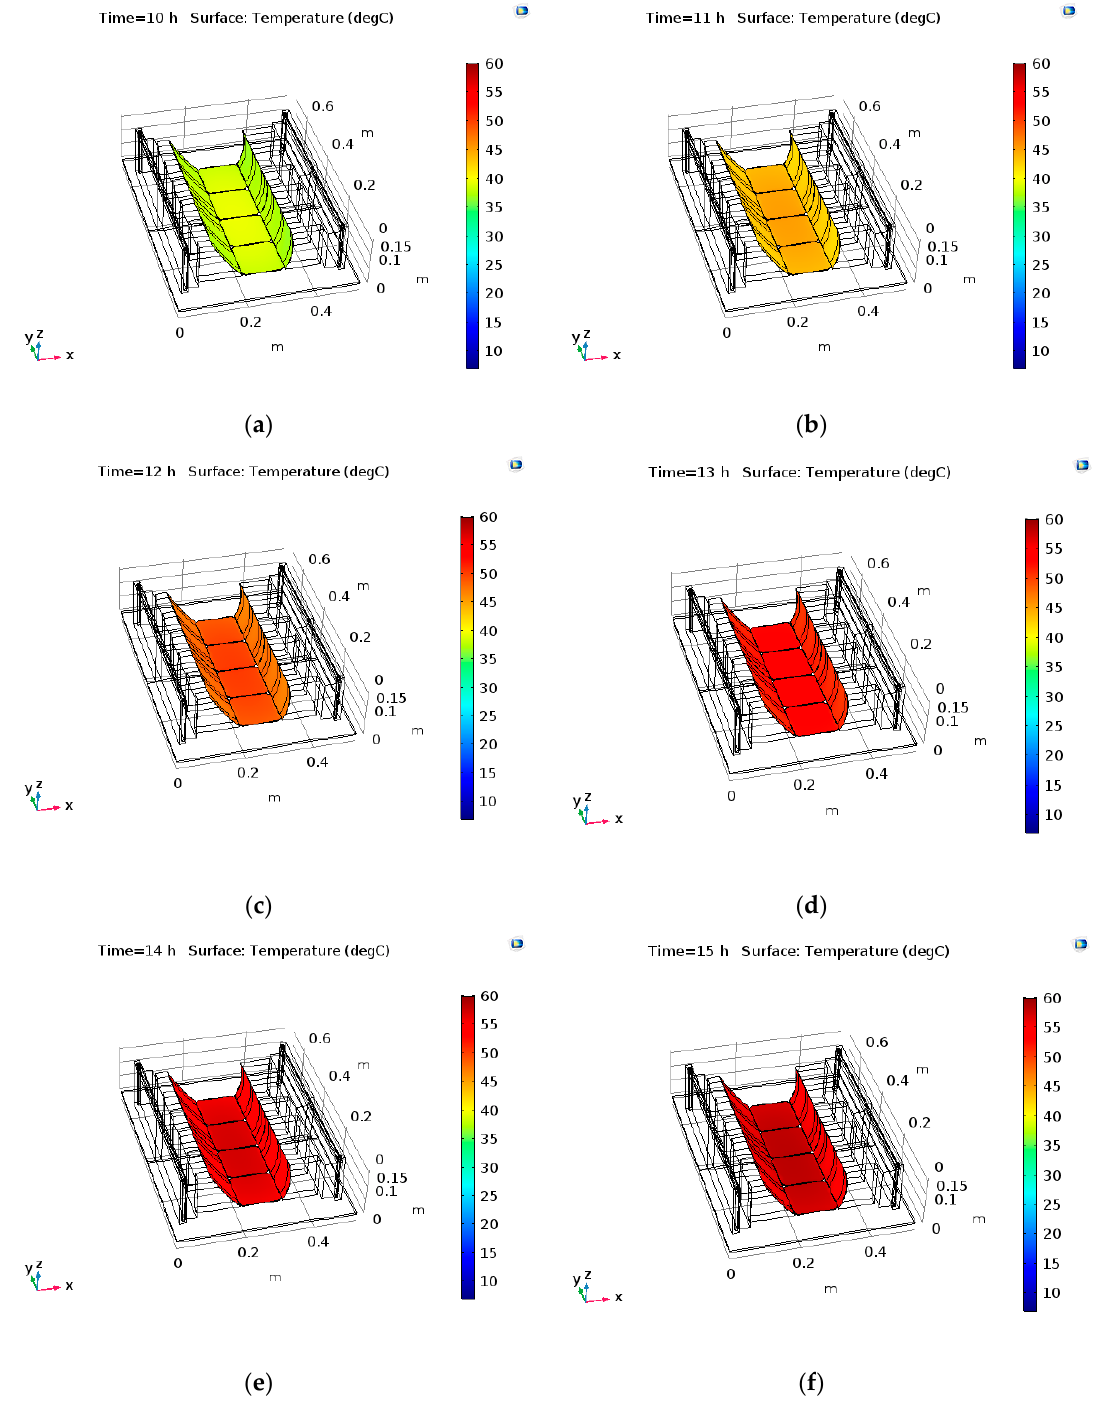
Figure A4. Temperature field on solar cells and reflectors surfaces for the uncovered CPC scenario (18 July 2017) at the following times: ( a ) 10:00; ( b ) 11:00; ( c ) 12:00; ( d ) 13:00; ( e ) 14:00; ( f ) 15:00.